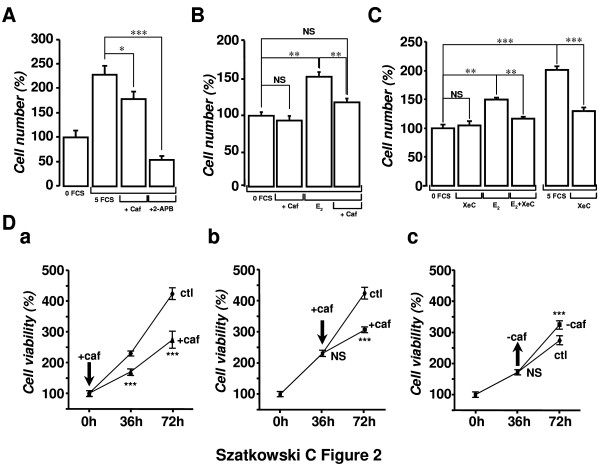
Pharmacological inhibitors of IP3Rs inhibited 5-FCS- and E2-induced MCF-7 cell growth. (A) The growth of MCF-7 cells induced by a 48 h treatment with 5-FCS was sensitive to pharmacological inhibitors of IP3R. Left bar graph shows the cell number obtained in 0-FCS and serves as a control experiment in order to estimate the proliferative effect of 5-FCS. Caffeine (500 μM) and 2-APB (75 μM) were both able to inhibit significantly 5-FCS-stimulated cell growth (P < 0.05 and P < 0.001, respectively). Values are the mean ± S.E.M. of 6 independent experiments. (B) Pharmacological inhibition of IP3R was responsible for the inhibition of E2-induced cell growth. Whereas caffeine (500 μM) was ineffective alone in control conditions, it inhibited the stimulation of cell growth by E2 (10 nM, P < 0.01). Values are the mean ± S.E.M. of 3 independent experiments. (C) XeC (10 μM) inhibited both 5-FCS and E2-induced MCF-7 cell growth. Values are the mean ± S.E.M. of 4 independent experiments. (D) Kinetics and reversibility of the inhibition by caffeine of E2-induced MCF-7 cell viability. Cells were starved for a 24 h period and were then stimulated by 10 nM E2. Caffeine (500 μM) was either added (+caf) at the beginning of the experiment (a), or after 36 h (b). In both cases, caffeine inhibited the E2-induced increase in cell viability (P < 0.001). The effect of caffeine was reversible since washout (-caf) of this compound after 36 h permitted to significantly restore the proliferative effect of E2 at 72 h (c). Arrows indicate the time of application (downward) or washout (upward) of caffeine. Values are the mean ± S.E.M. of 3 independent experiments.